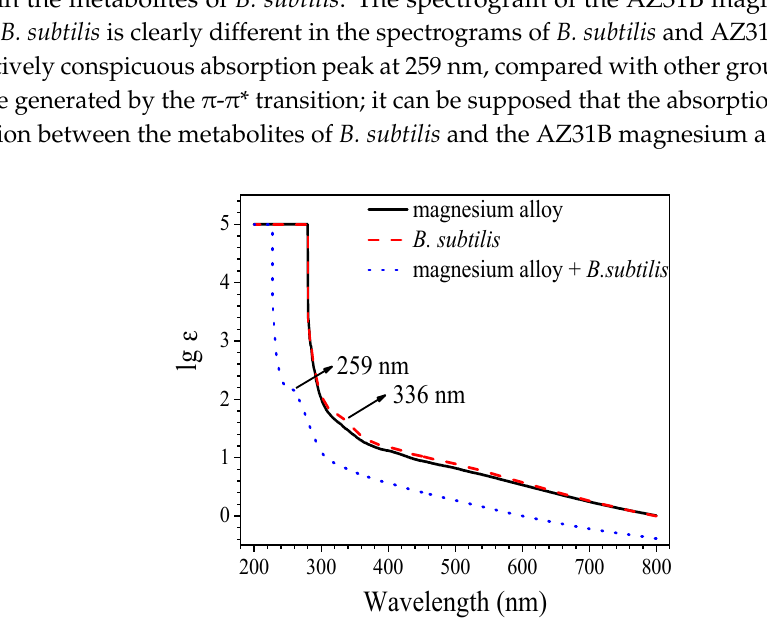
Figure 7. UV-VIS analysis of the AZ31B magnesium alloy, B. subtilis , and AZ31B magnesium alloy with inoculation of B. subtilis at 48 h.